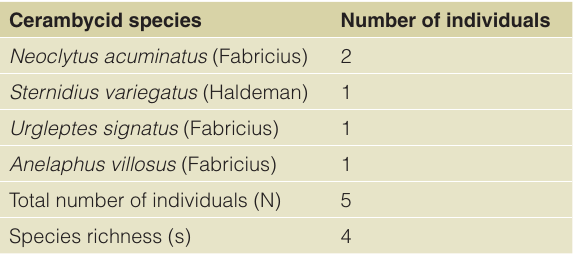
Table 7. Cerambycid (Coleoptera: Cerambycidae) Species Captured in Fuller Preserve, 2008 (Central Wood County, OH). Total number of individuals of each species caught during the entire trapping period (early June to early October). Traps were positioned in the approximate center of each forest and all checked each week.